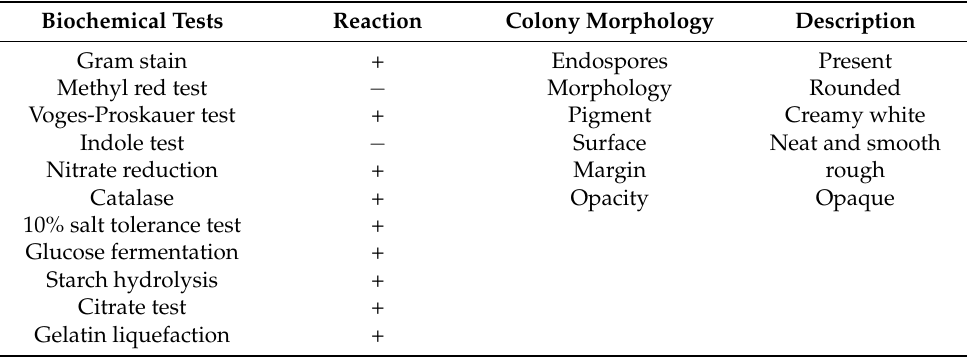
Table 2. Physiological and biochemical characteristics of antagonistic strain